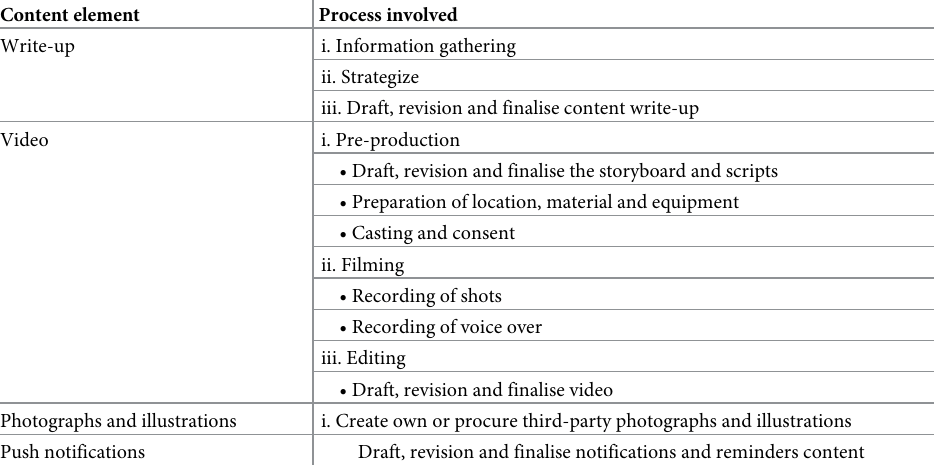
Table 2. Content elements and process